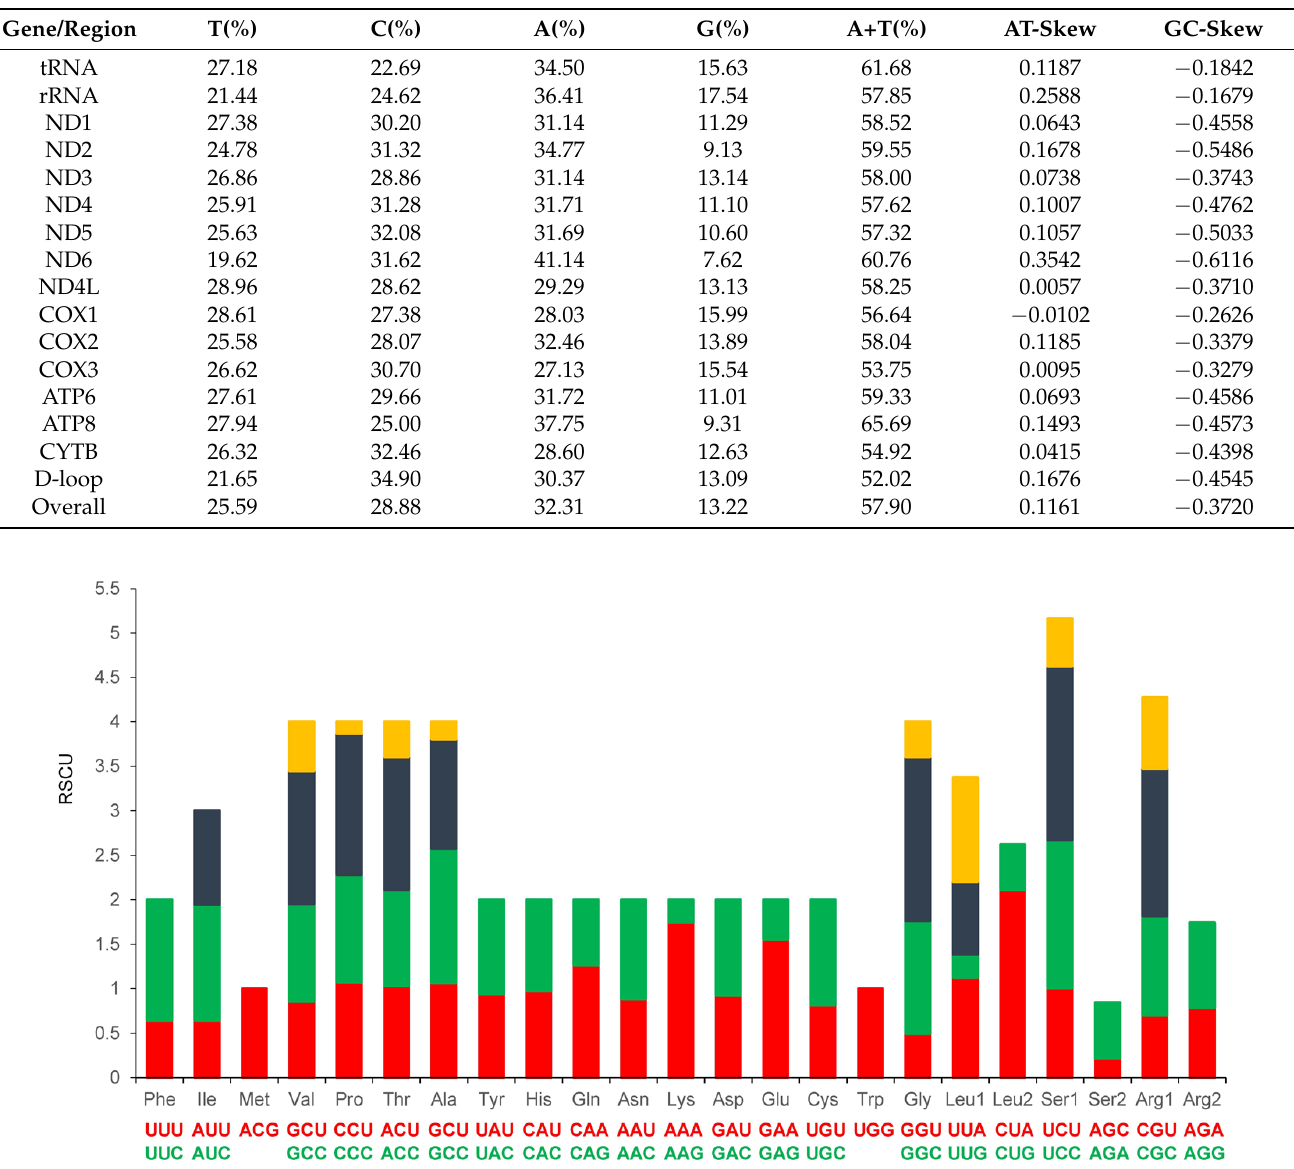
Table 2. Composition and skew values in different regions of mitochondrial genome of Huaibei grey donkey.